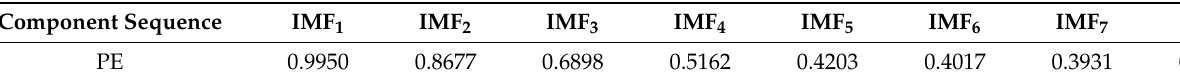
Table 2. Permutation of entropy values by IMF component.